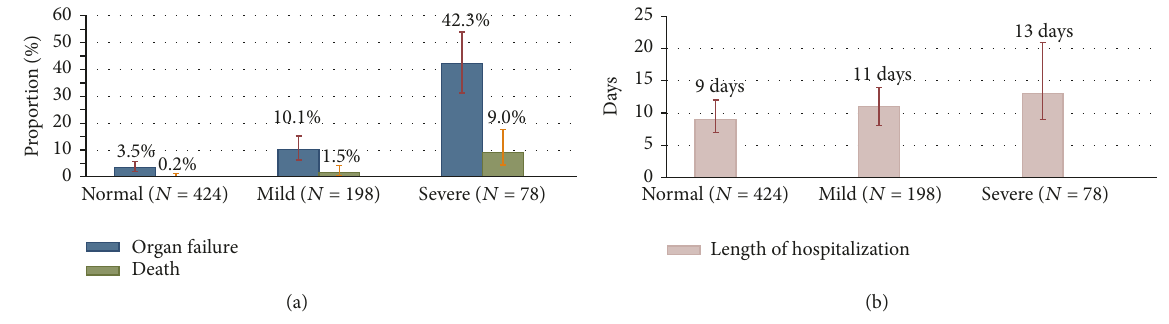
Figure 1: Trends of median hospital days, incidence of persistent organ failure, and mortality in acute pancreatitis patients with normal, mild, and severe low serum